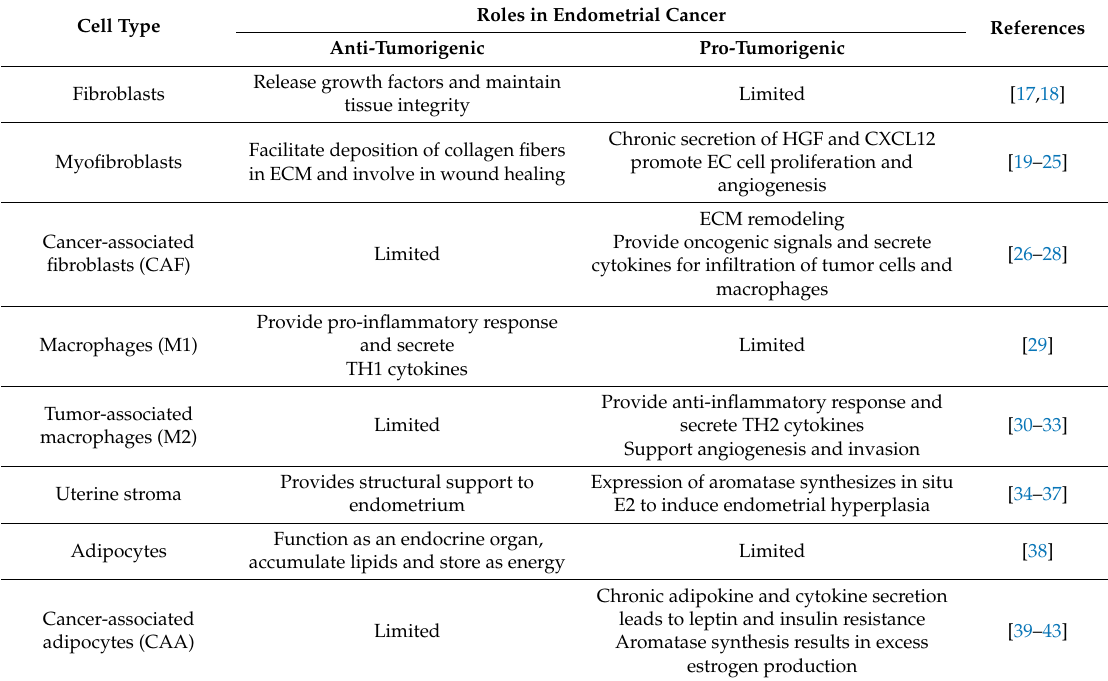
Table 1. The stromal cell population in endometrial cancer (EC) microenvironment has distinct functions during